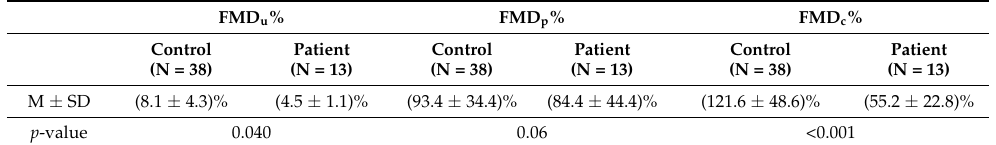
Table 2. The results (mean ± standard deviation) of FMD u . FMD p and FMD c in control and patient groups.